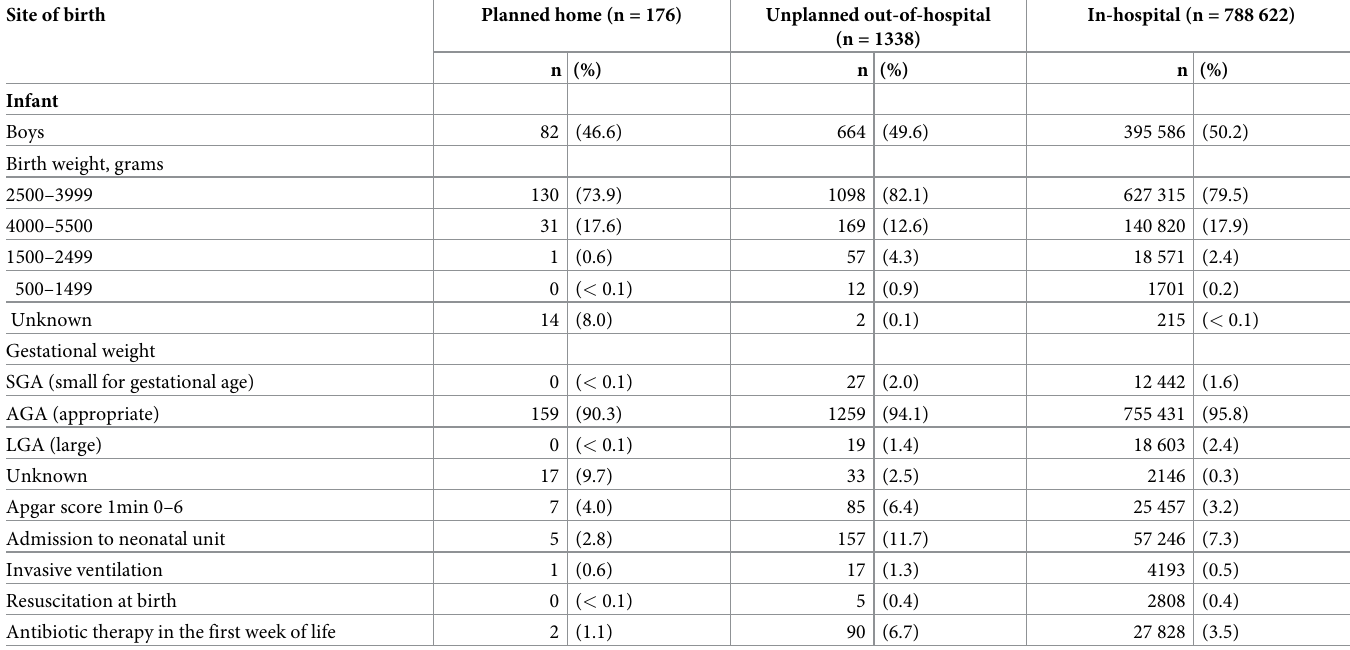
Table 2. Characteristics of infants alive at age of seven days (n = 790 136).